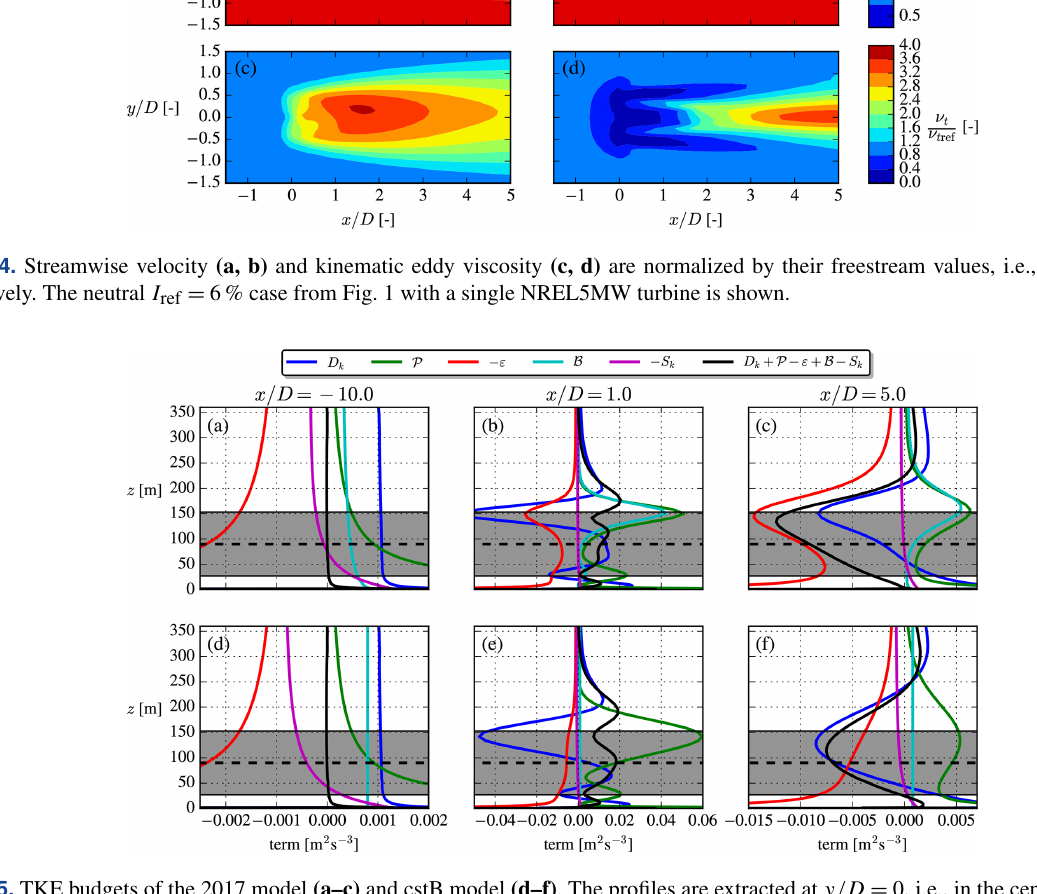
Figure 5. TKE budgets of the 2017 model (a–c) and cstB model (d–f) . The profiles are extracted at y/D = 0, i.e., in the center of the wake. ζ ref = − 0 . 5 and I ref = 12% for both